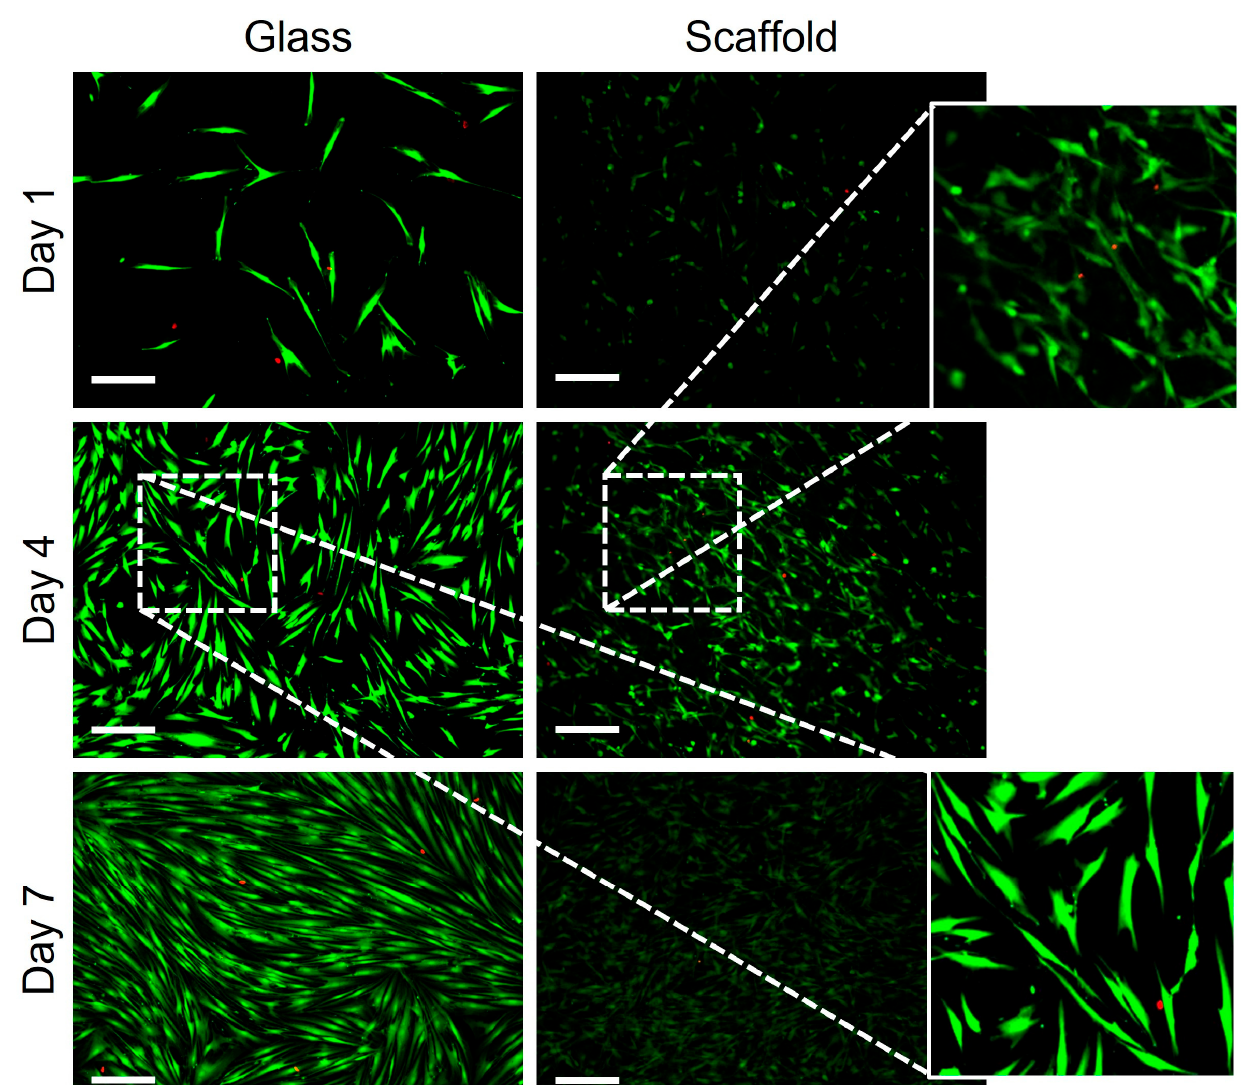
Figure 4. Representative live dead fluorescent images taken at day 1, 4, and 7 during the post seeding of normal oral fibroblasts onto PCL scaffolds and glass cover slips. The same image enhancement using ImageJ software to subtract background fluorescence and increase brightness was used for all images. Live cells are stained green and dead cells are stained red. Scale bar (white) is equal to 200 μ m.